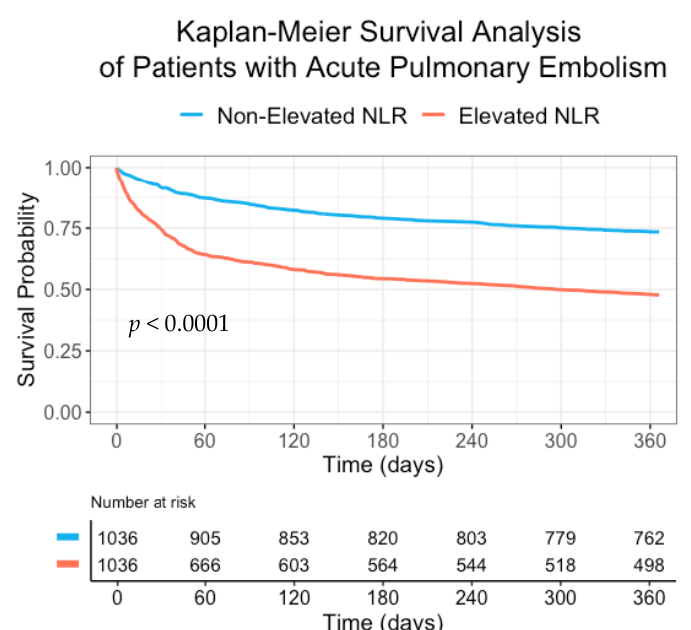
Figure 1. Kaplan–Meier survival curves for elevated and non-elevated NLR in patients hospitalized with acute pulmonary embolism.